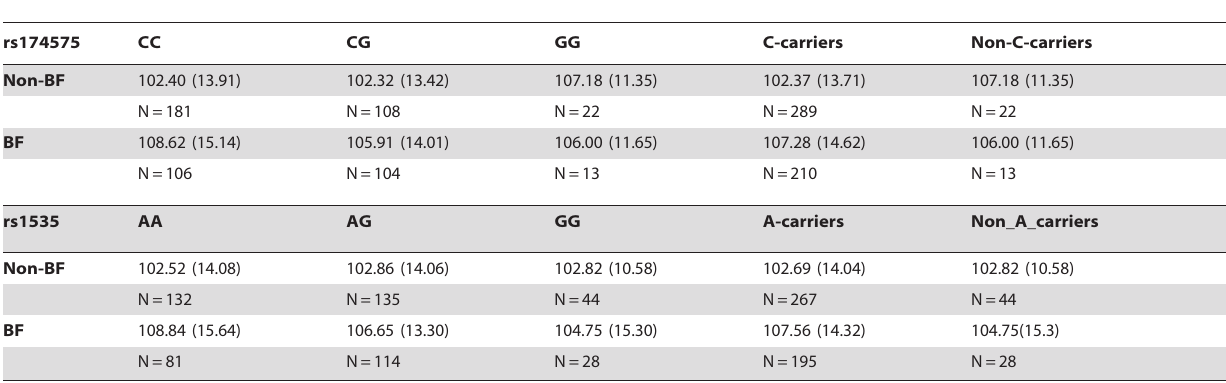
Table 1. Mean (SD) IQ scores, across different genotype and BF groups.